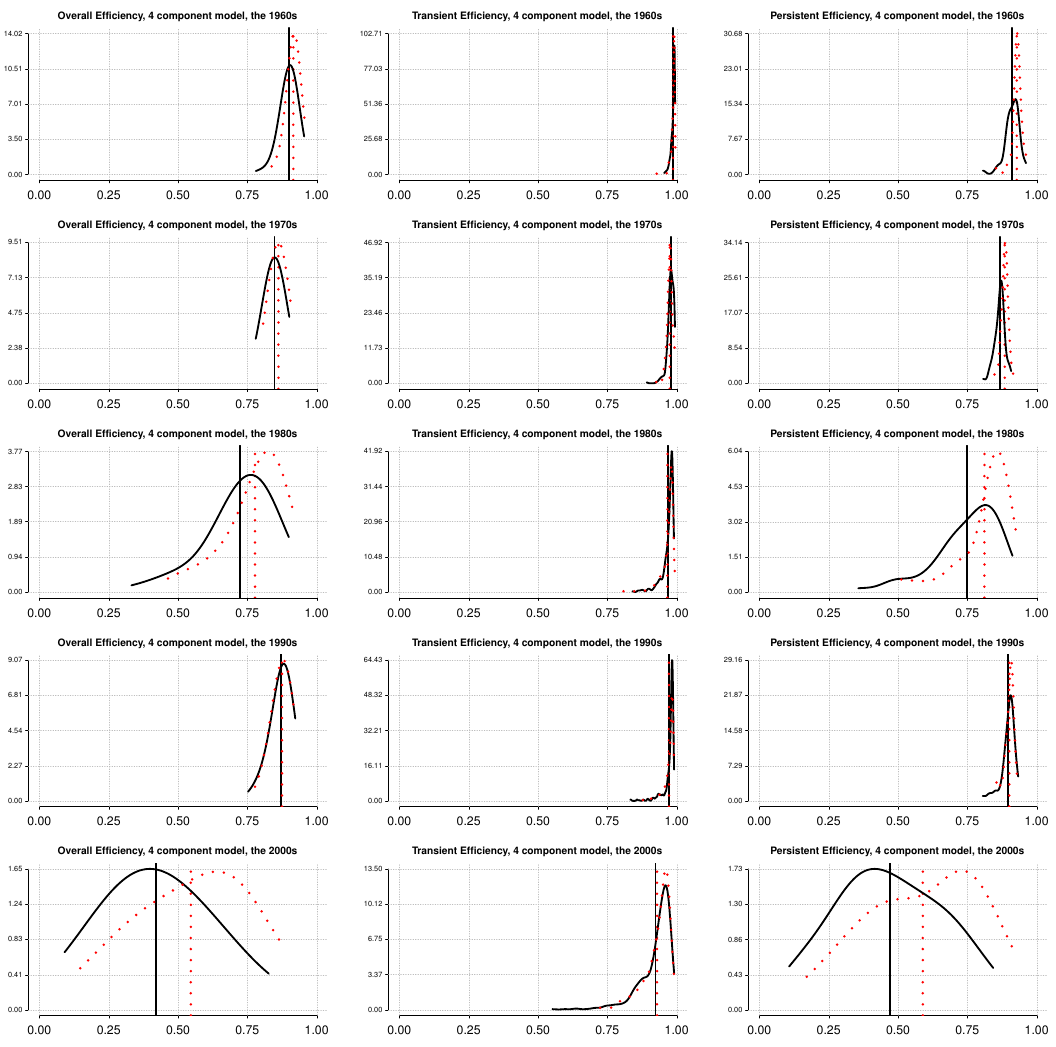
Figure 4. Overall, transient and persistent energy efficiency, Model 1. Notes: Solid black curves are high energy-intensive industries, dotted red curves are low energy-intensive industries. Vertical lines are respective mean